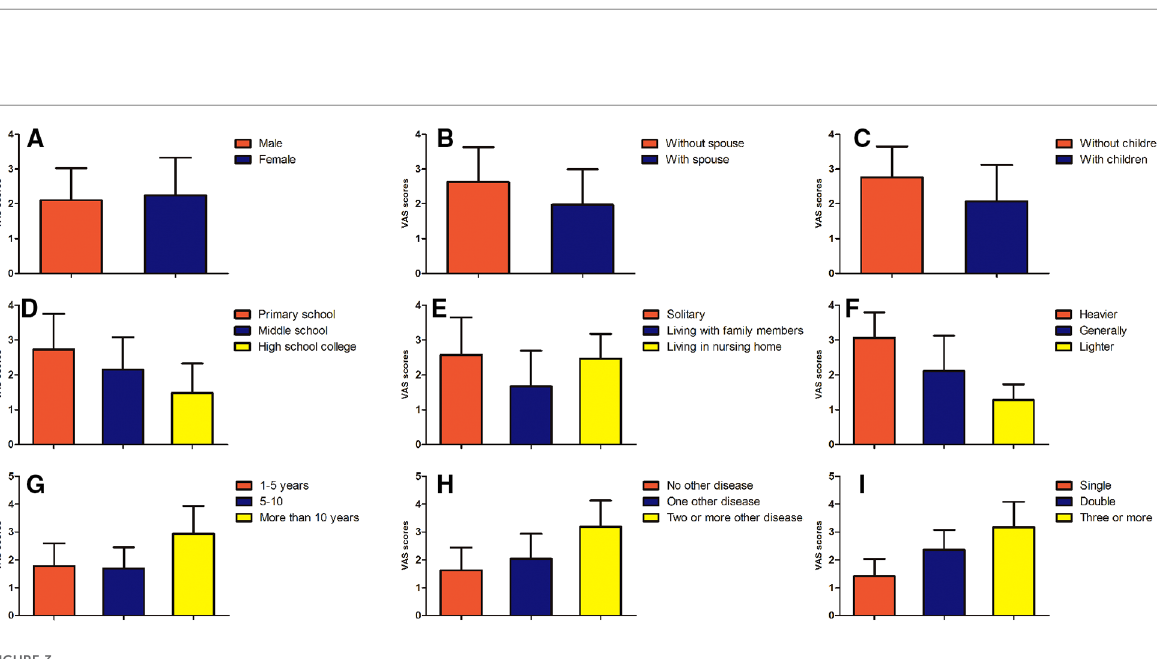
FIGURE 3 Comparison of JOA scores after lumbar fusion in different demographic characteristics. Comparison of JOA scores after lumbar fusion in different situations, such as gender ( A ), marital status ( B ), with or without children ( C ), education level ( D ), living status ( E ), economic pressure ( F ), disease duration ( G ), suffering from other diseases ( H ) and the number of surgical segments ( I